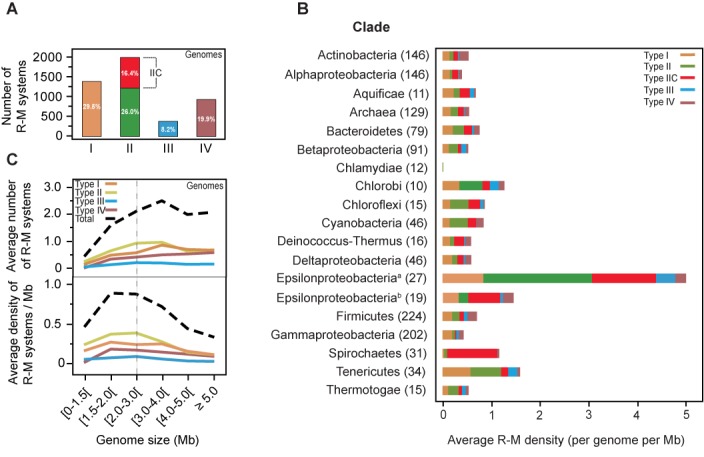
Quantification and distribution of R-M systems in 2261 prokaryotic genomes. (A) Amount of Types I, II, IIC, III R-M systems and Type IV REases found in genomes. Corresponding percentages are indicated. (B) Average R-M density (per genome per Mb) according to clade. The largest peak on R-M density observed for Epsilonproteobacteria (a) results from the presence of multiple systems particularly among Helicobacter species. For comparison, we also show the density for Epsilonproteobacteria without Helicobacter (b). Only clades with at least 10 different species were considered for comparison. The number of species within each clade is indicated next to its name. (C) Distribution of the average number of R-M systems per genome (upper graph) and average density per genome per Mb (bottom graph) according to genome size (Mb). Stippled line separates the regions having small and large genomes. Genomes of Helicobacter were not included to avoid obtaining extremely inflated values in the [1.5–2.2[ Mb genome size range.